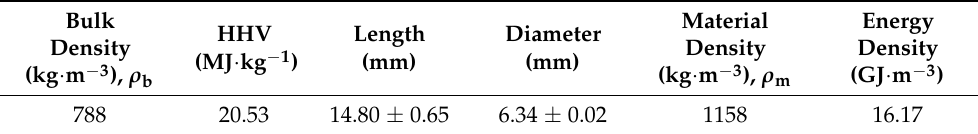
Table 2. The physical characteristics of densified black